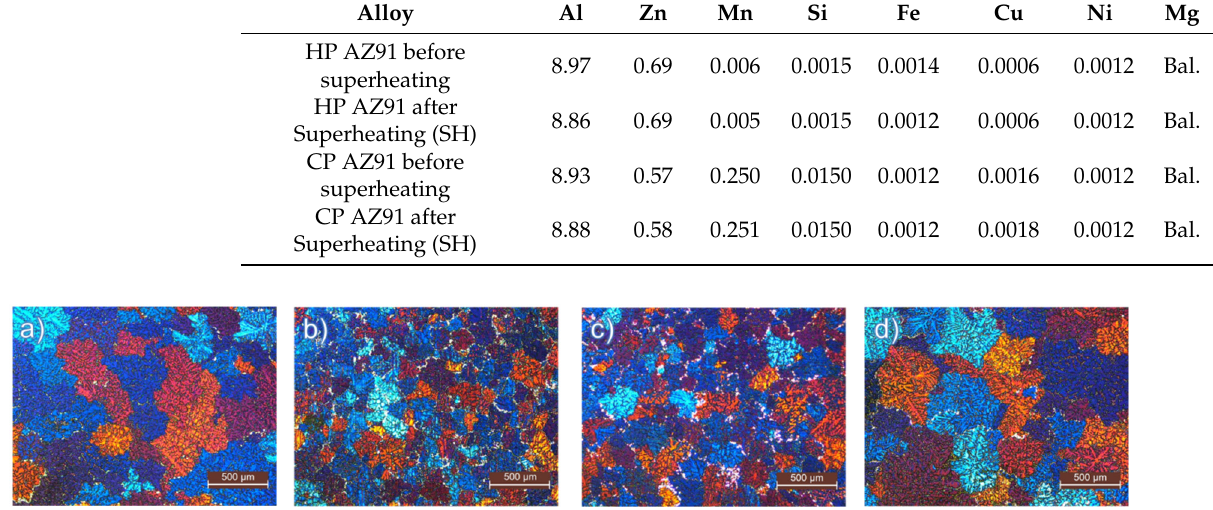
Figure 3. Influence of superheating and holding on the grain size for ( a ) CP AZ91 (AGS: 290 μ m), ( b ) CP AZ91 SH (AGS: 114 μ m), ( c ) CP AZ91 SH-1h (AGS: 121 μ m), and ( d ) CP AZ91 SH-2h (AGS: 290 μ m).